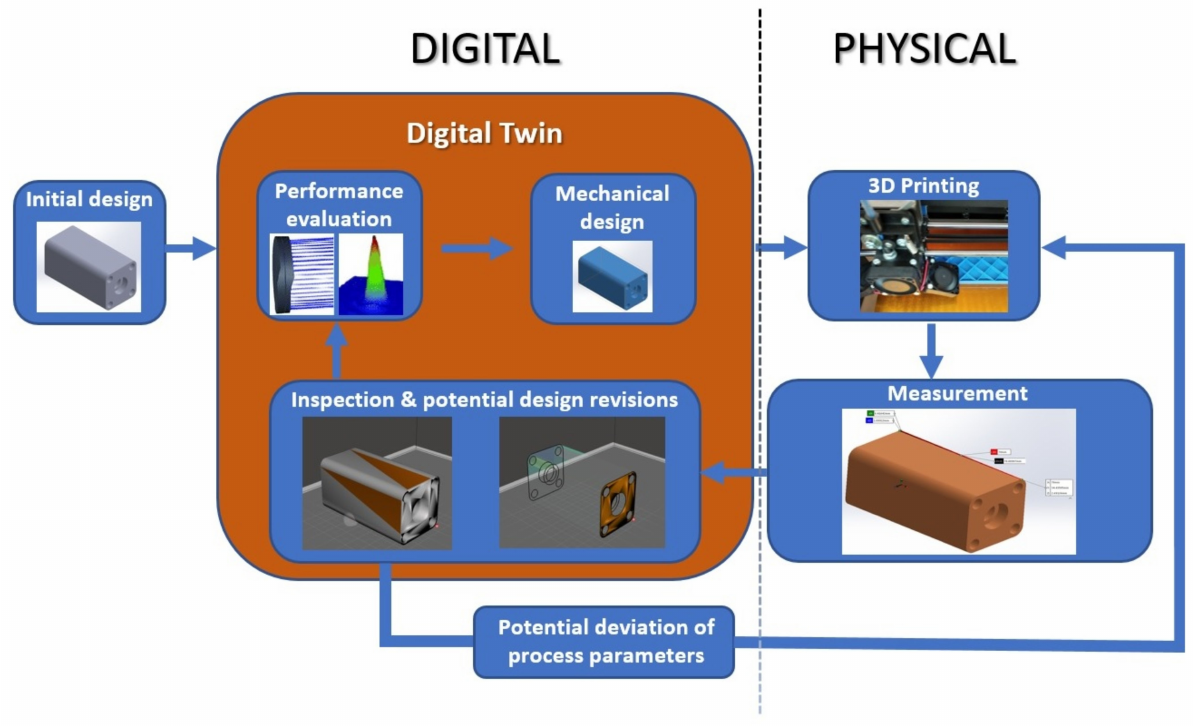
Figure 5. Process workflow of a digital twin in additive